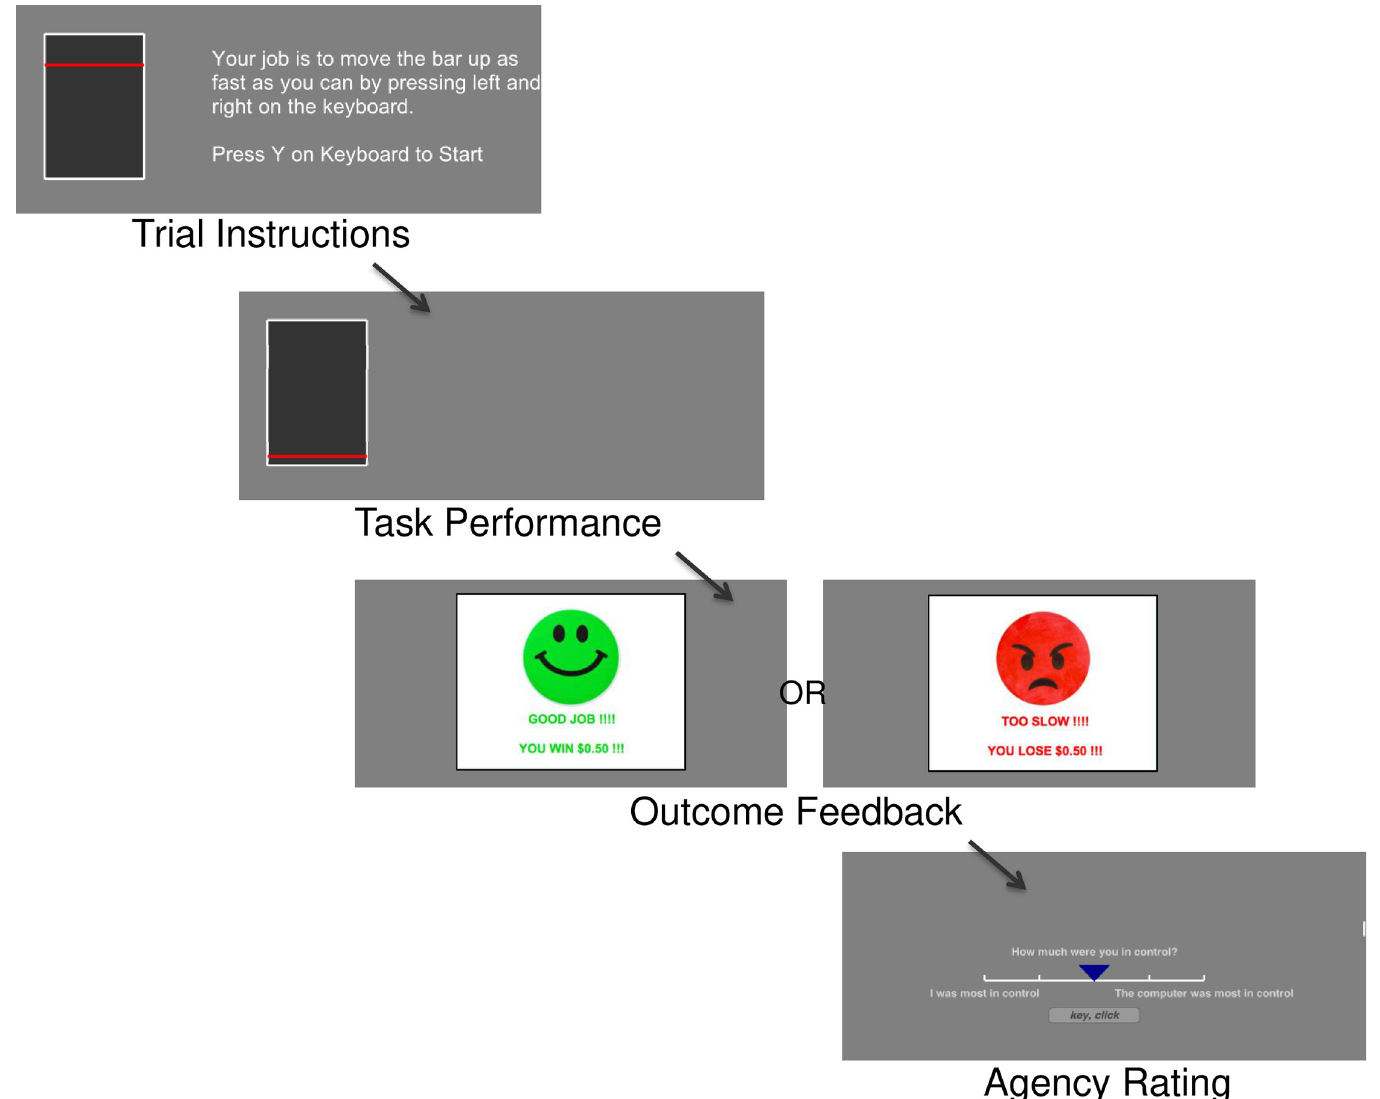
Fig 1. Self-agency task (SAT) schematic. On each trial, subjects perform a simple button press effort task for monetary reward. Subjects then gain positive-win or negative-loss feedback based on their reaction time relative to their own baseline reaction time. Following feedback, subjects are instructed to rate the level of agency for that trial on a 5-point Likert scale (1 = self, 5 =